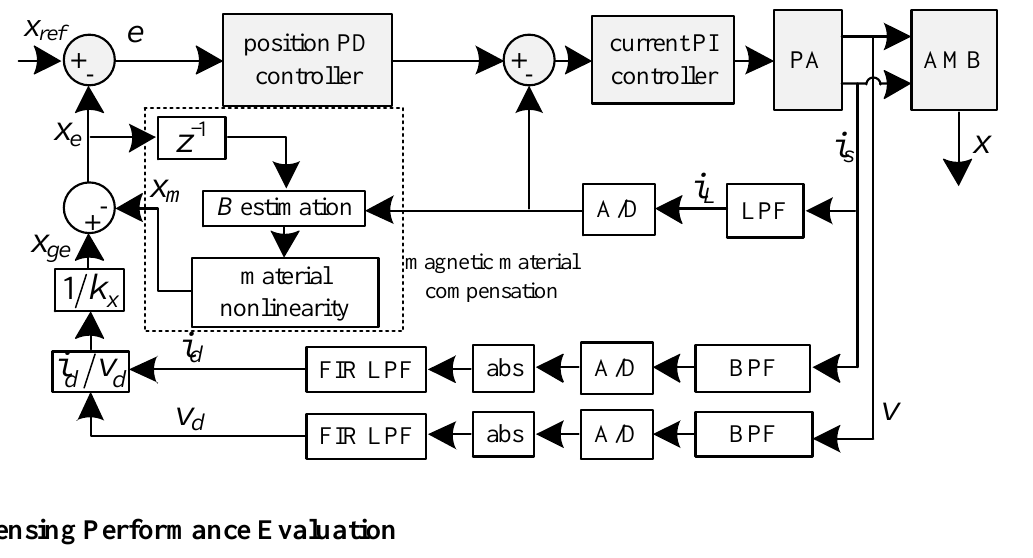
Figure 11. Configuration of the digital modulation position estimator.